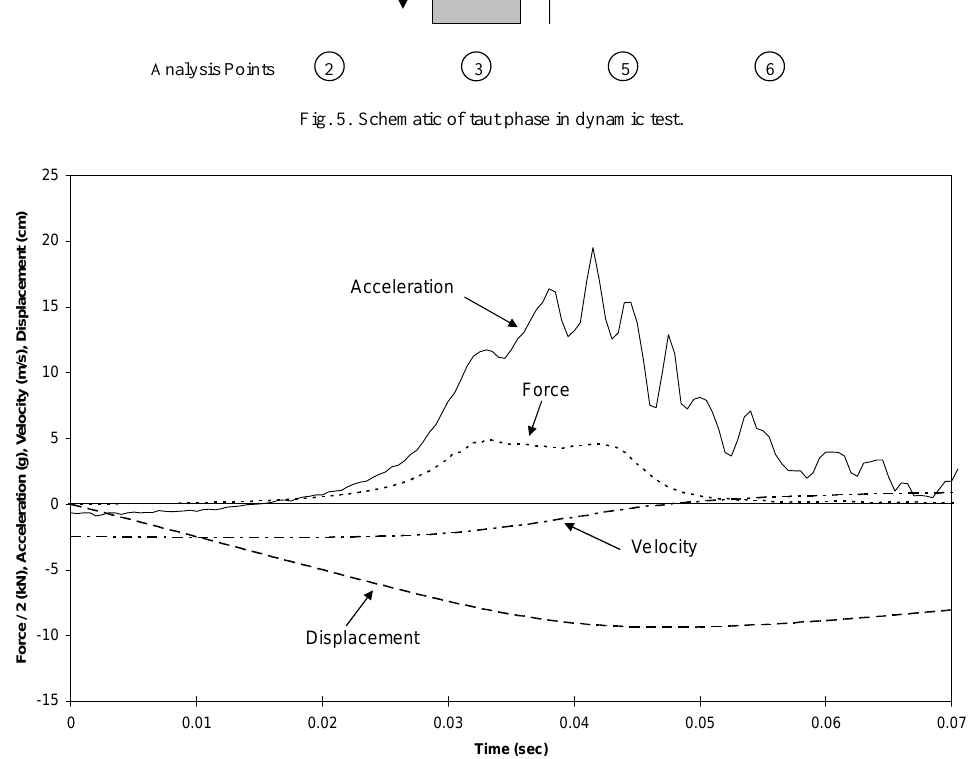
Fig. 6. Same test as in Fig. 4, showing first snap load; displacement